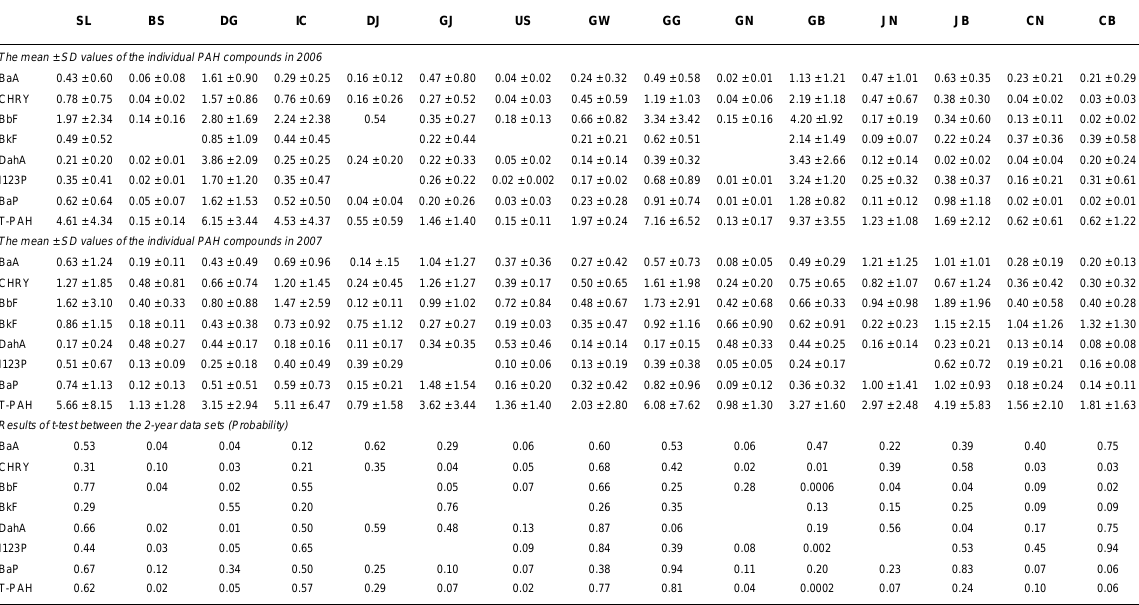
Results of t-Test for PAH Concentrations of a Given City Measured between 2006 and 2007